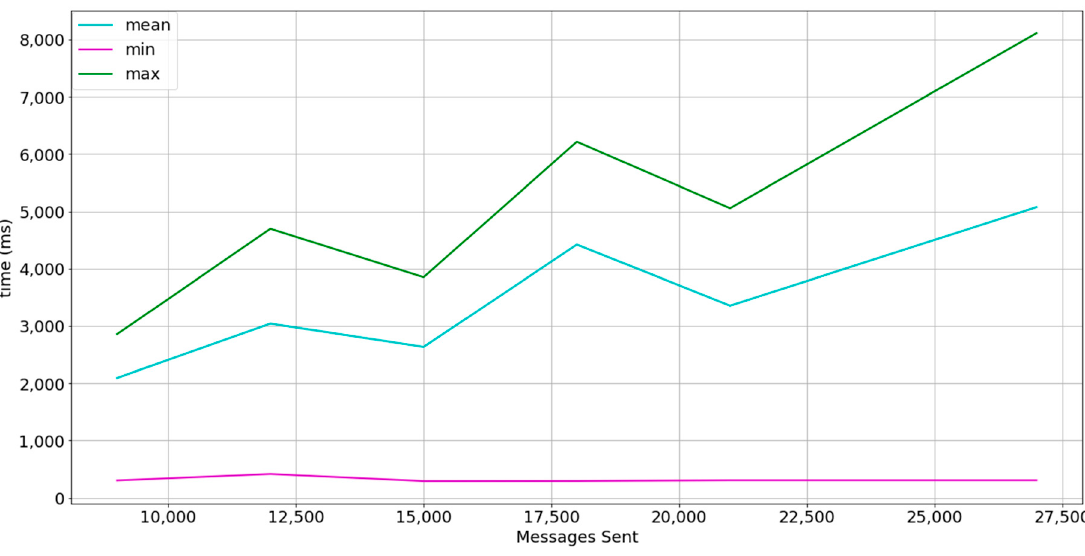
Figure 9. Results in experiment description setting 1 at a 5-s interval between bursts. The line in cyan represents the mean timedelta, the line in magenta represents the minimum timedelta, and the green line represents the maximum timedelta. 5.2. Experiment 2 The experiment description setting 2 is similar to the experiment description setting 1 but instead of increasing the number of simulated devices, it emulates the aggregation of messages in the payload field. The experiment shows 1000 devices sending messages with payloads that aggregate messages, emulating that each device is a Smart Gateway that aggregates messages. Table 4 summarizes the experiment description.